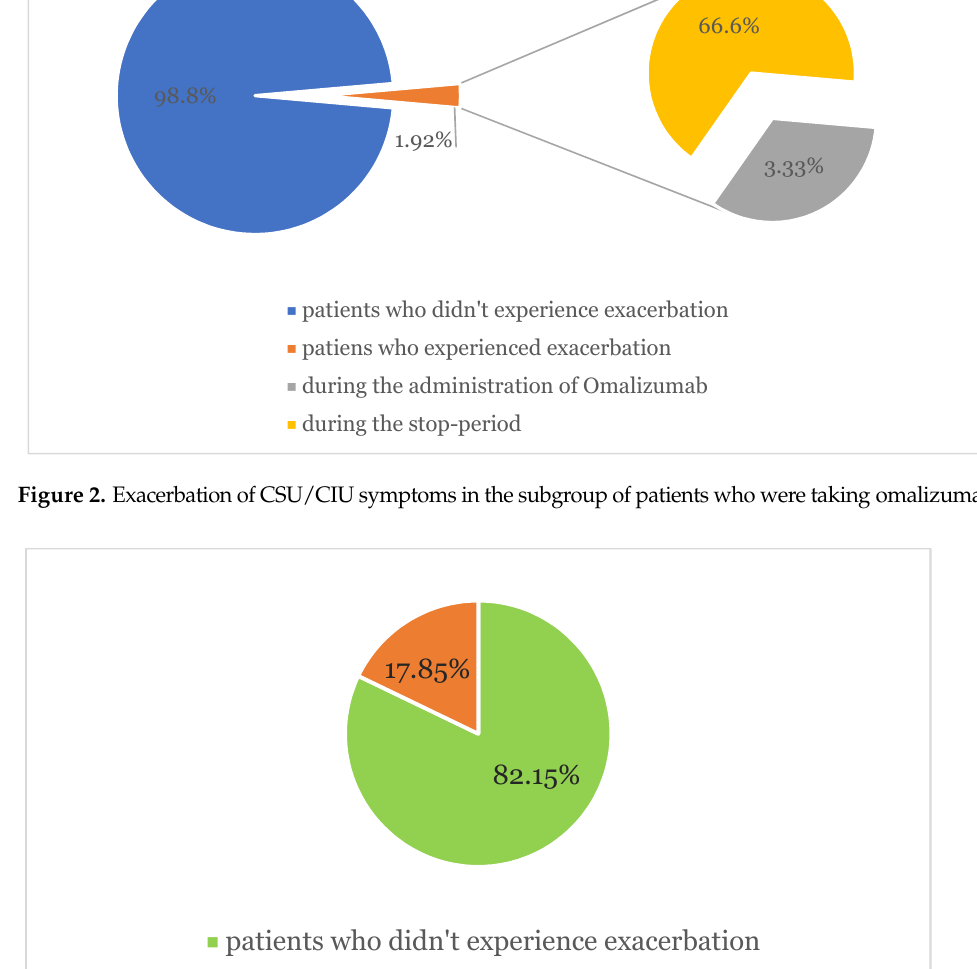
Figure 3. Exacerbation of CSU/CIU symptoms in the subgroup of patients who were taking anti-H1 therapy .